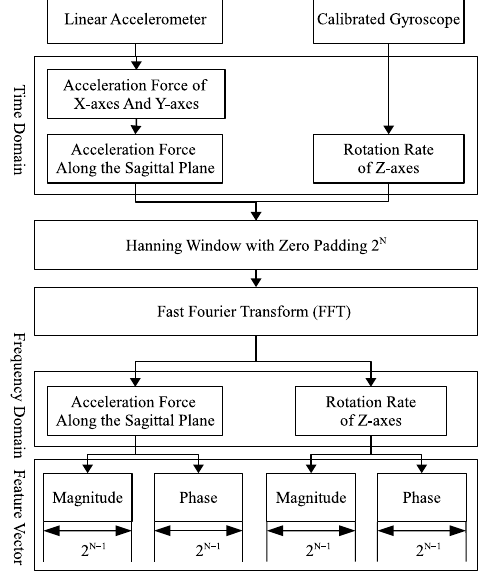
Figure 3. The process of feature